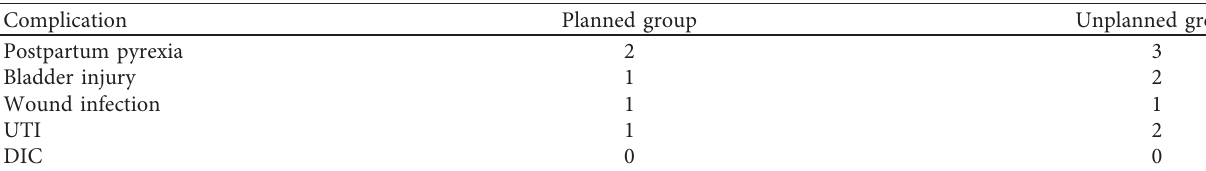
Table 3: List of surgical complications.